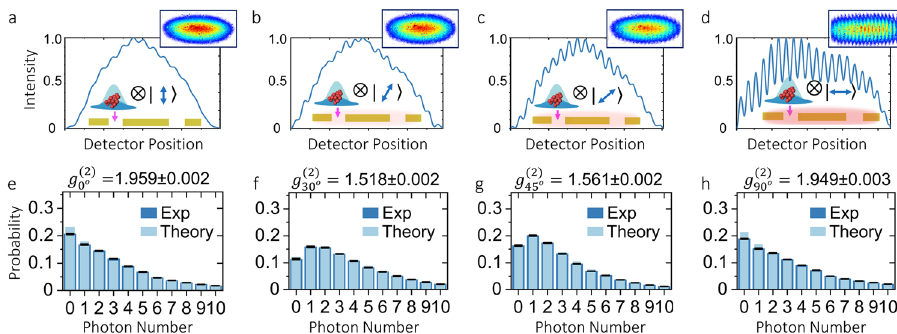
Fig. 2 Experimental observation of plasmon-induced interference and the modi fi cation of quantum statistics. The formation of interference fringes in the far fi eld of the plasmonic structure with two slits is shown in panels ( a – d ). Panel ( a) shows the spatial distribution of a thermal multiphoton system transmitted by a single slit. In this case, the contribution from optical near fi elds is negligible and no photons are transmitted through the second slit. As shown in panel ( b ), a rotation of the photon ’ s polarization increases the presence of optical near fi elds in the plasmonic structure. In this case, photon- plasmon scattering processes induce small changes to the spatial distribution of the transmitted photons. Part ( c ) shows that the increasing excitation of plasmons is manifested through the increasing visibility of the interference structure. Panel ( d ), shows a clear modi fi cation of spatial coherence induced by optical near fi elds. Remarkably, the modi fi cation of spatial coherence induced by the presence of plasmons is also accompanied by the modi fi cation of the quantum statistical fl uctuations of the fi eld as indicated in panels ( e – h ). Each of these photon-number distributions corresponds to the spatial pro fi les above from ( a ) to ( d ). The photon-number distribution in ( e ) demonstrates that the photons transmitted by the single slit preserve their thermal statistics. Remarkably, multiparticle scattering induced by the presence of near fi elds modi fi es the photon-number distribution of the hybrid system as shown in ( f ) and ( g ). These probability distributions resemble those of coherent light sources. Interestingly, as demonstrated in ( h ), the photon-number distribution becomes thermal again when photons and plasmons are polarized along the same direction. The error bars represent the standard deviation of ten datasets. Each dataset consists of ~400,000 photon-number-resolving measurements.